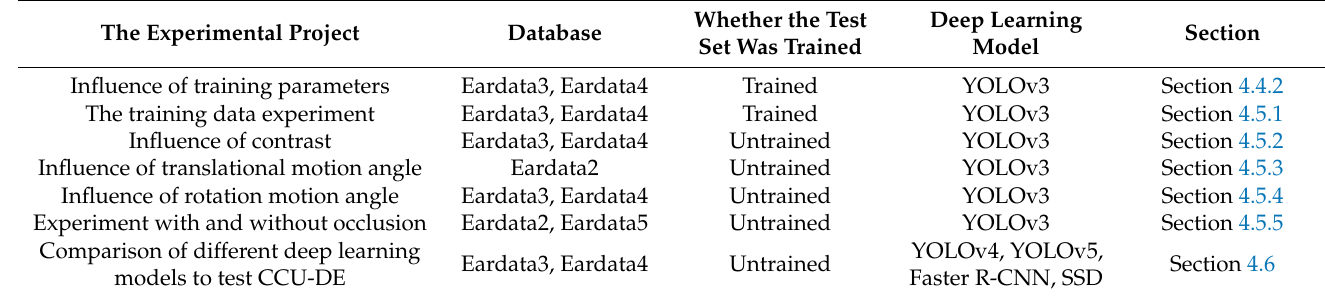
Table 16. The experiment in this